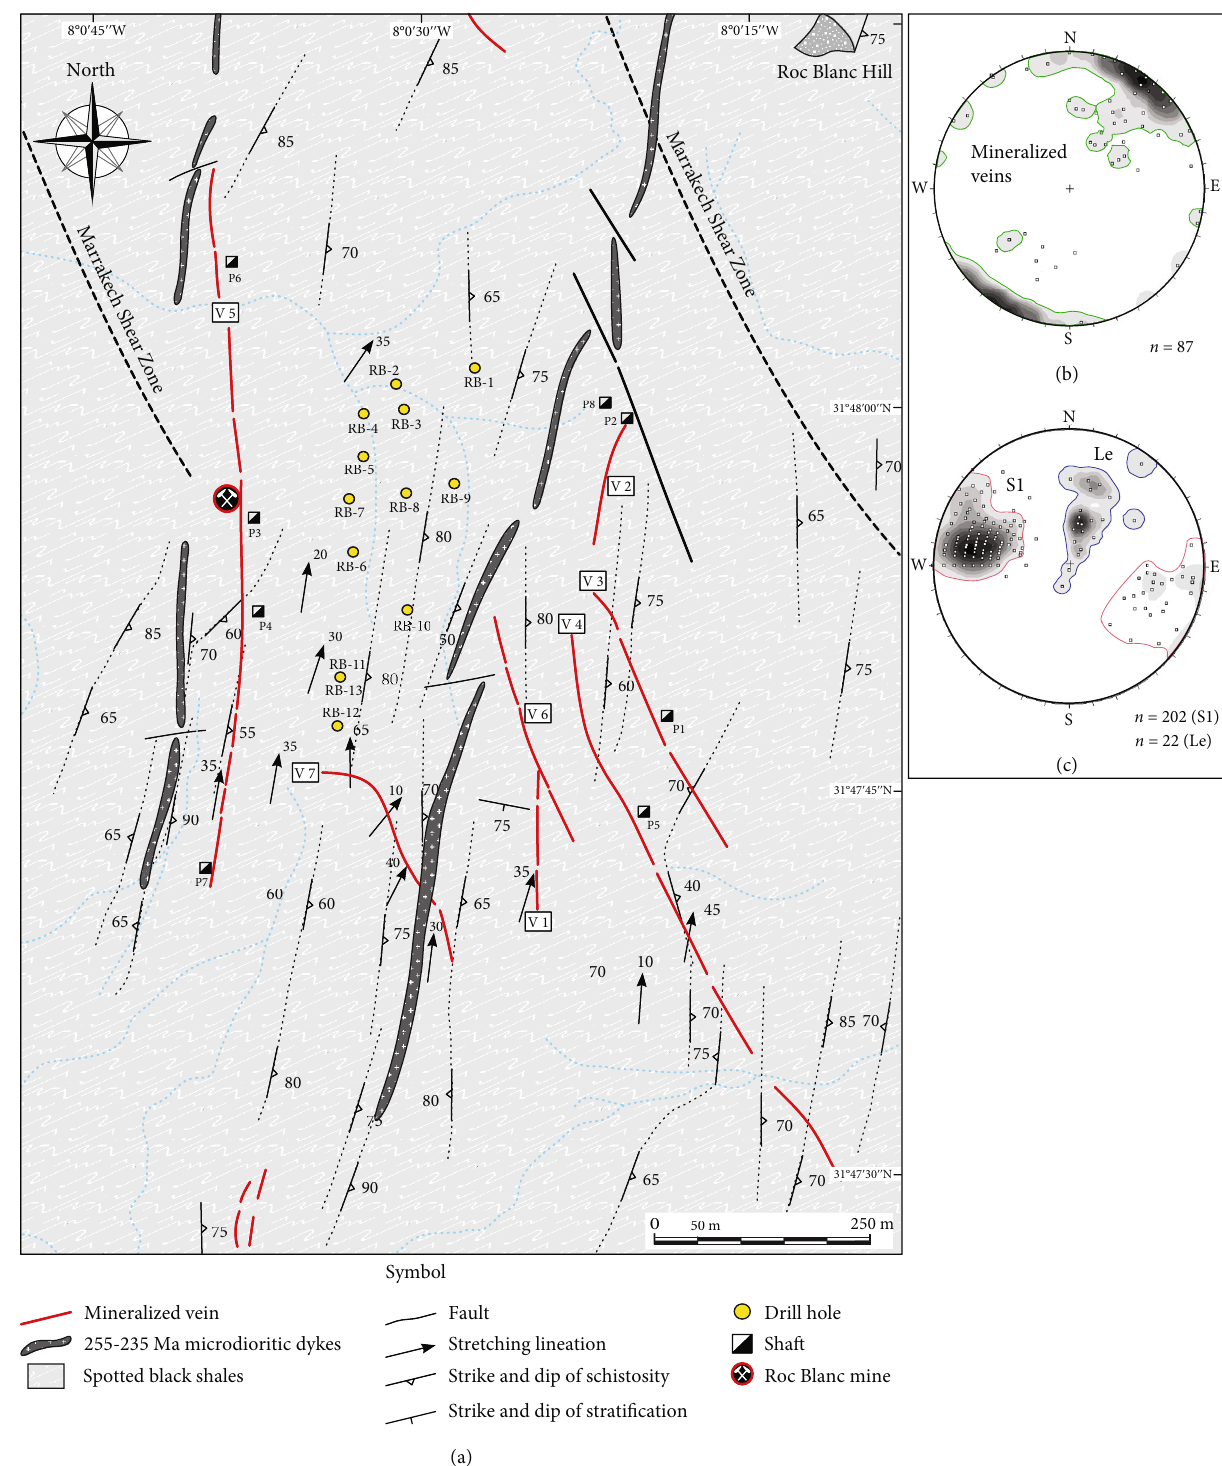
Figure 2: (a) Geologic map of the Roc Blanc deposit showing the distribution and morphology of Pb-Zn-Ag-Au veins. Note the spatial relationship between the mineralised veins, microdiorite, and dolerite and the organic-rich black shale (Sarhlef schists). Location of drill cores (projected to surface) [4]. (b) Stereogram of hydrothermal veins from Roc Blanc deposit ( n = 87 measured points). (c) Stereogram ( n = 202 ) and L e ( n = 22 ) values measured in the Roc Blanc of S 1